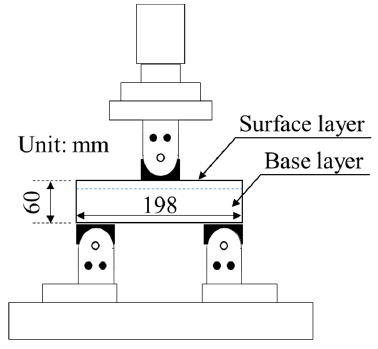
Figure 3. Details of the placement of the specimen in the rig.